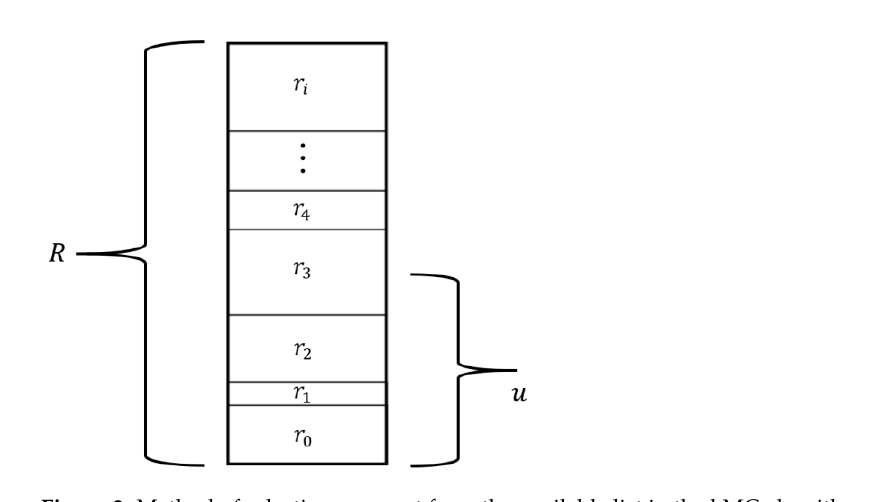
Figure 3. Method of selecting an event from the available list in the kMC algorithm.